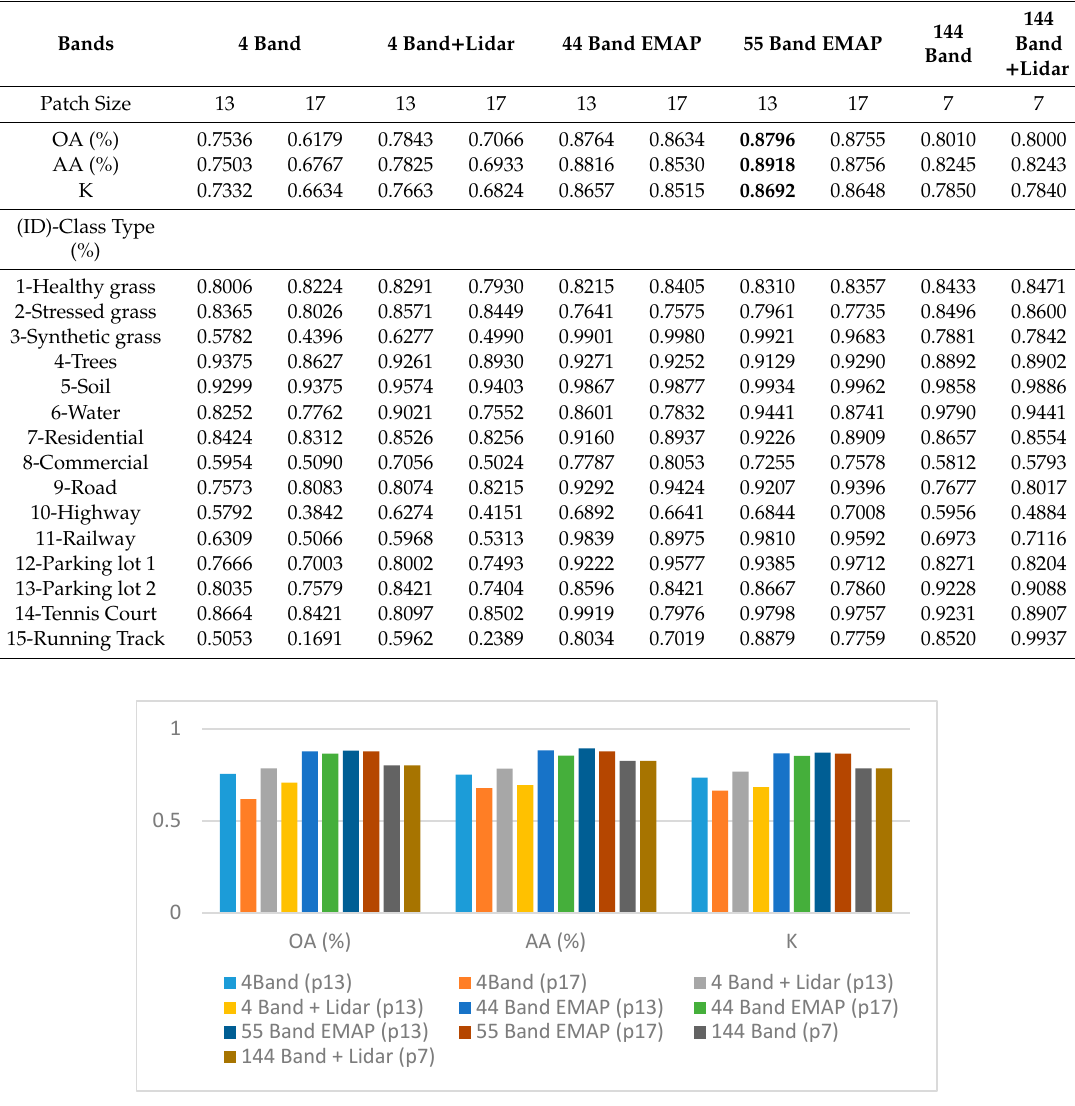
Table 3. CNN-3D classification results for the test dataset with six di ff erent sets of image bands. Bold numbers indicate best performing datasets for each row.